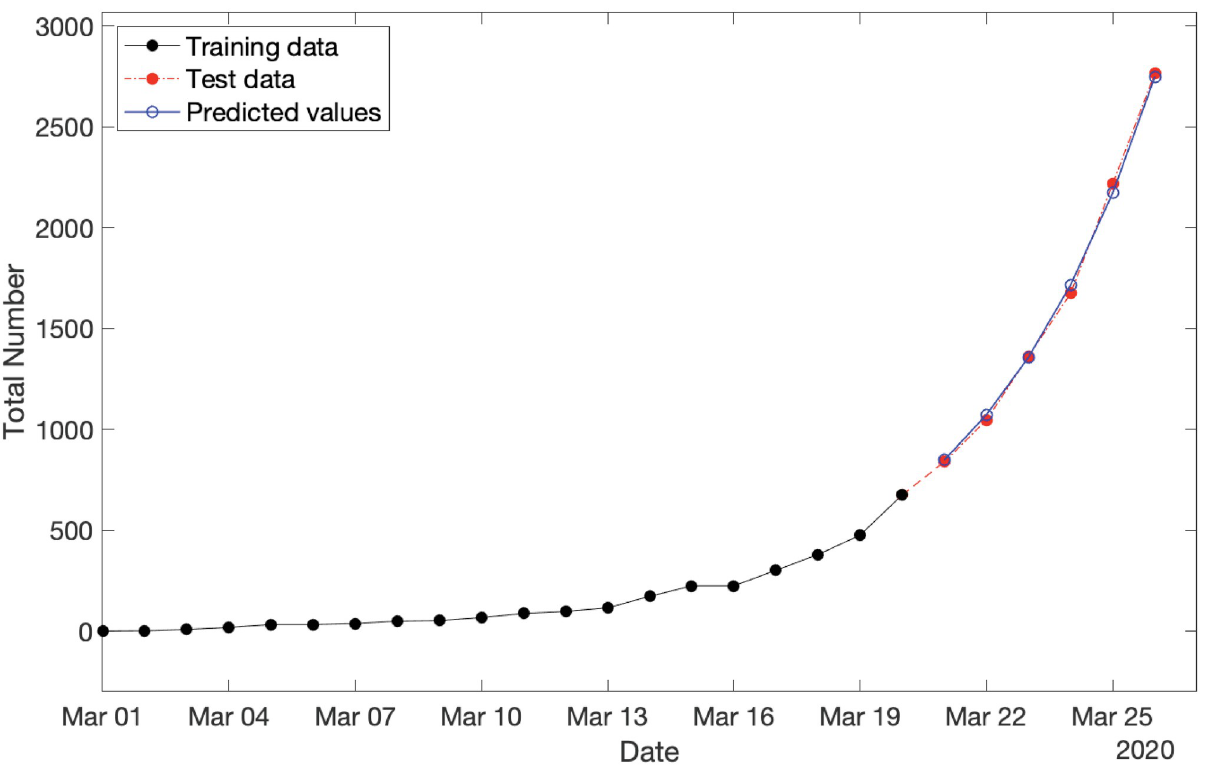
Fig 2. Cumulative new COVID-19 cases in Australia for three categories consisting of: (i) training data spanning from 1 − 20 March 2020 (in black), test data spanning from 21 − 26 March 2020 (in red), and (iii) predicted values over the period of test data (in blue) with MAPE = 1.53%.